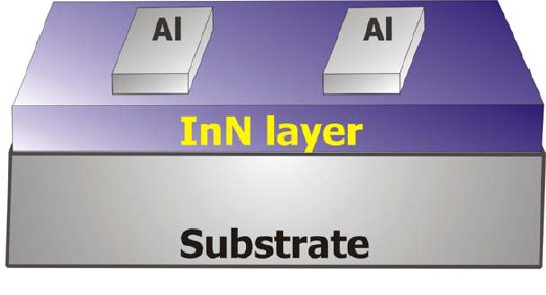
Figure 3. Schematic diagram of the fabricated InN-on-PET condensation sensor. The contact pads (Al) have an area of 2 mm 2 × 1 mm 2 and the distance between them is 2